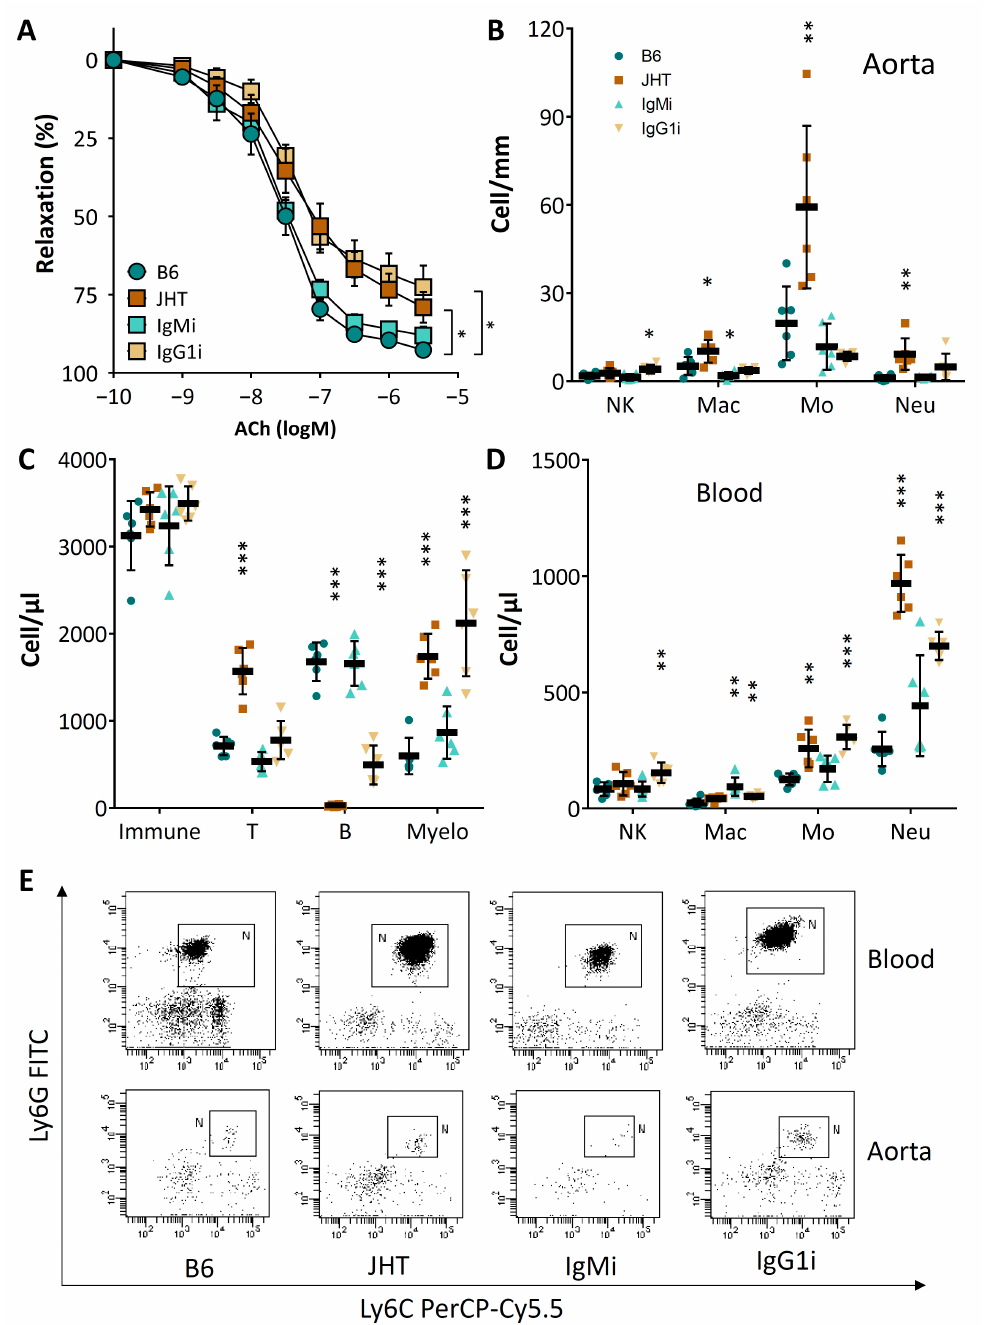
Figure 4. Vascular dysfunction in JHT and IgG1i mice is associated with neutrophilia. Vascular function ( A ) and immune cell profiles in aorta ( B ) and blood ( C , D ) were analyzed with samples from 7 week-old wild-type C57BL/6J, JHT, IgMi and IgG1i mice, respectively. Panel ( E ) shows flow cytometry of neutrophils in blood and aorta, respectively. Symbols in panel A represent mean ± SEM; n = 12. The horizontal lines in the scatter dot plots in panels B-D represent mean ± SD. * p < 0.05, ** p < 0.01, *** p < 0.001, compared with wild-type mice (B6); two-way ANOVA.